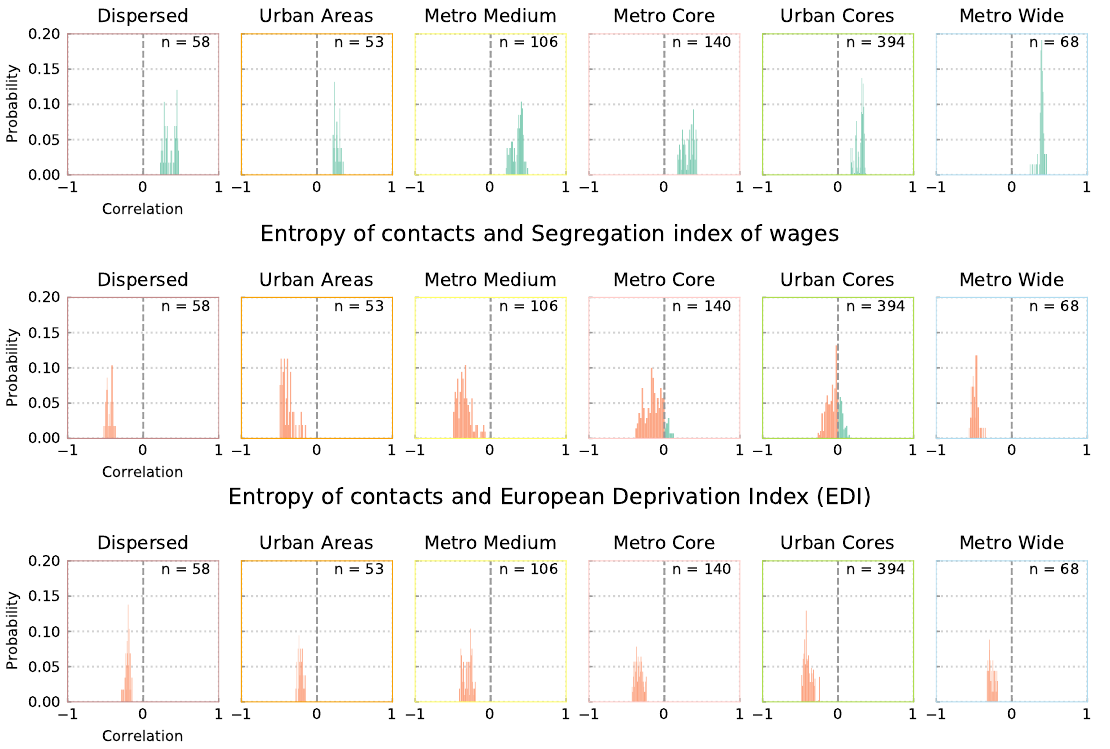
Figure 7. Distributions of the Spearman correlation coefficient for the relation between the Entropy of contacts and the different socioeconomic indicators. Correlation coefficients are calculated for all 4914 city definitions but the histograms group results by the different classes of city definitions as defined in Figure 3. The bars in the histograms are coloured green when correlation coefficients are positive and orange when negative. The colours outlining the histograms accord to the different classes as defined in Figure